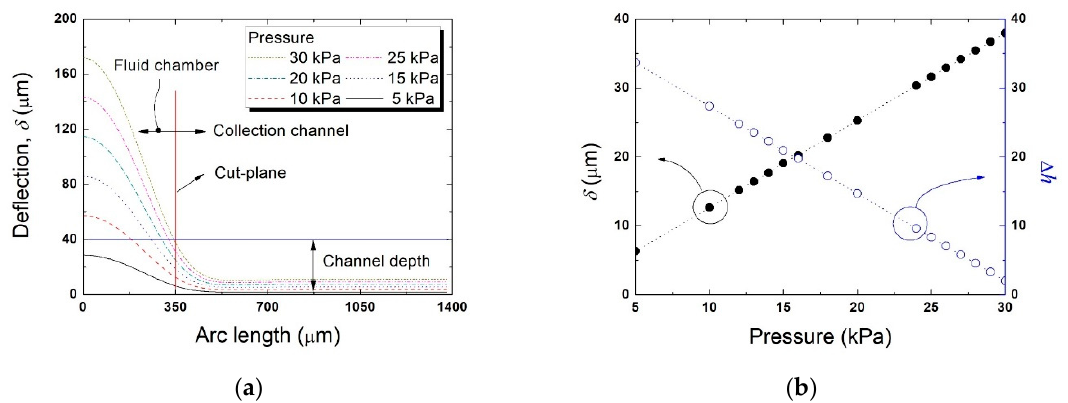
Figure 6. Simulation of polydimethylsiloxane (PDMS) valve diaphragm deflection (in the y–z plane) by applied pressure. ( a ) Deflection of the valve diaphragm within the particle collection region and the fluid chamber of the Vs, ( b ) maximum diaphragm deflection ( δ ) at the cut-plane (x–z plane) and the height difference ( Δ h ) between this deflection and the central depth of the collection channel (40 µm).